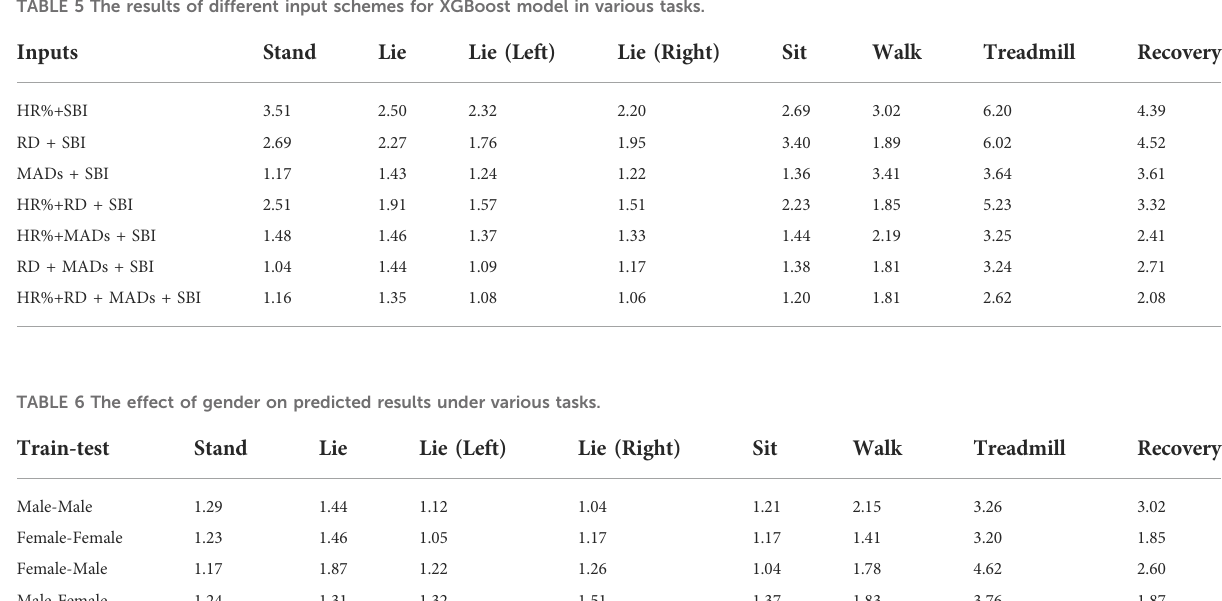
Table 5. RD is more closely related to VO 2 than HR in rest and low-